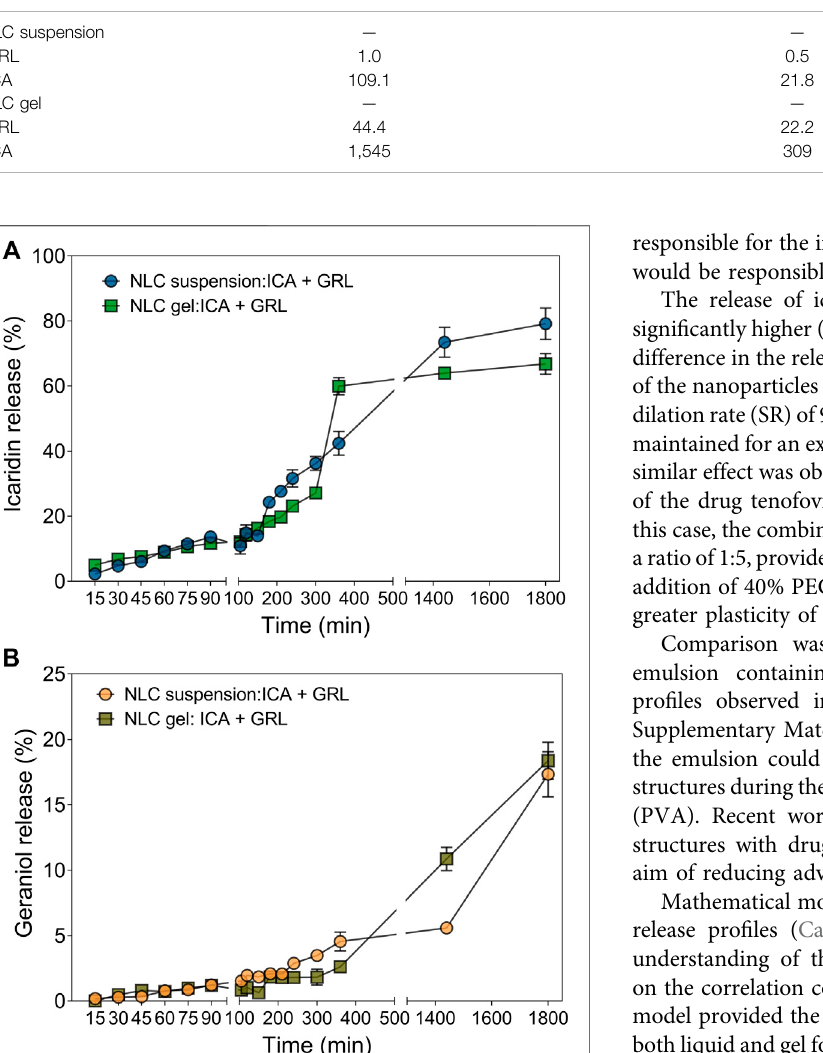
TABLE3| Parametersforpermeationofgeraniol(GRL)andicaridin(ICA)acrossStrat-M ® membranesfromthesuspensionandgelformulationsofNLCscontaining5%ICA +2% GRL. Formulations